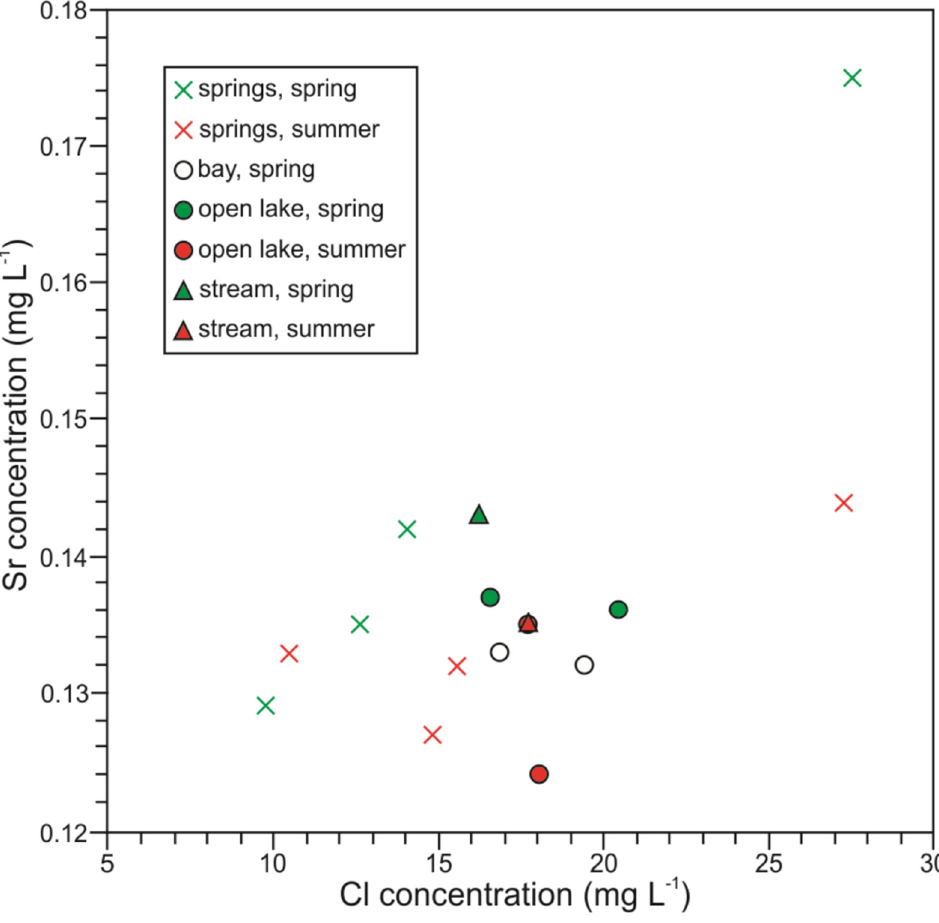
Figure 9. Relationship between Cl and Sr in samples collected from the springs and Lubi´nskie Lake. Chlorine content in the lake was measured only for surface and near bottom waters (see Table 4).